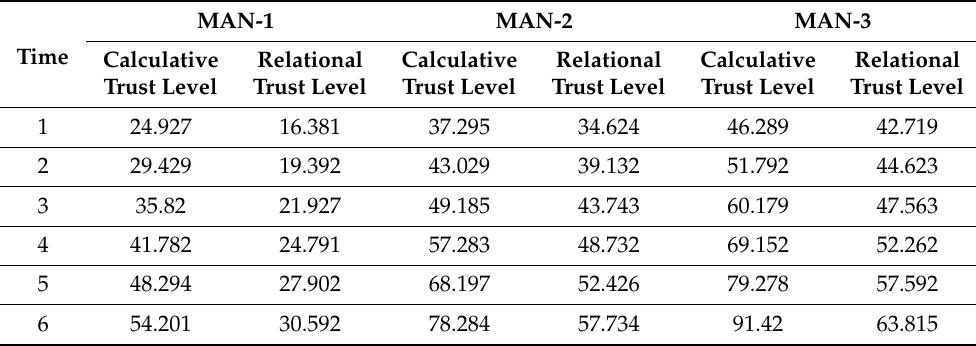
Table 2. Scenario A simulation